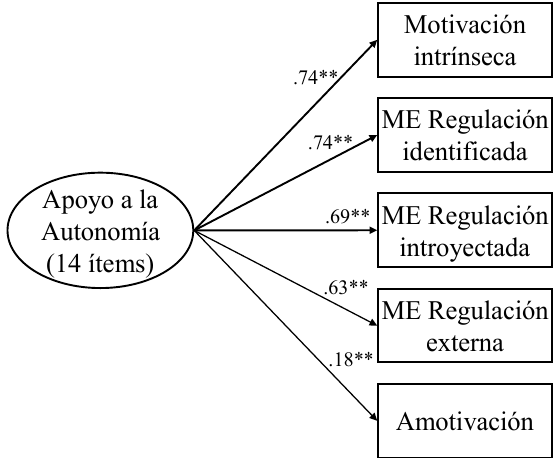
Figura 2. Solución estandarizada del modelo estructural hipo- tetizado (t-value>1.96) para la validez convergente (variables